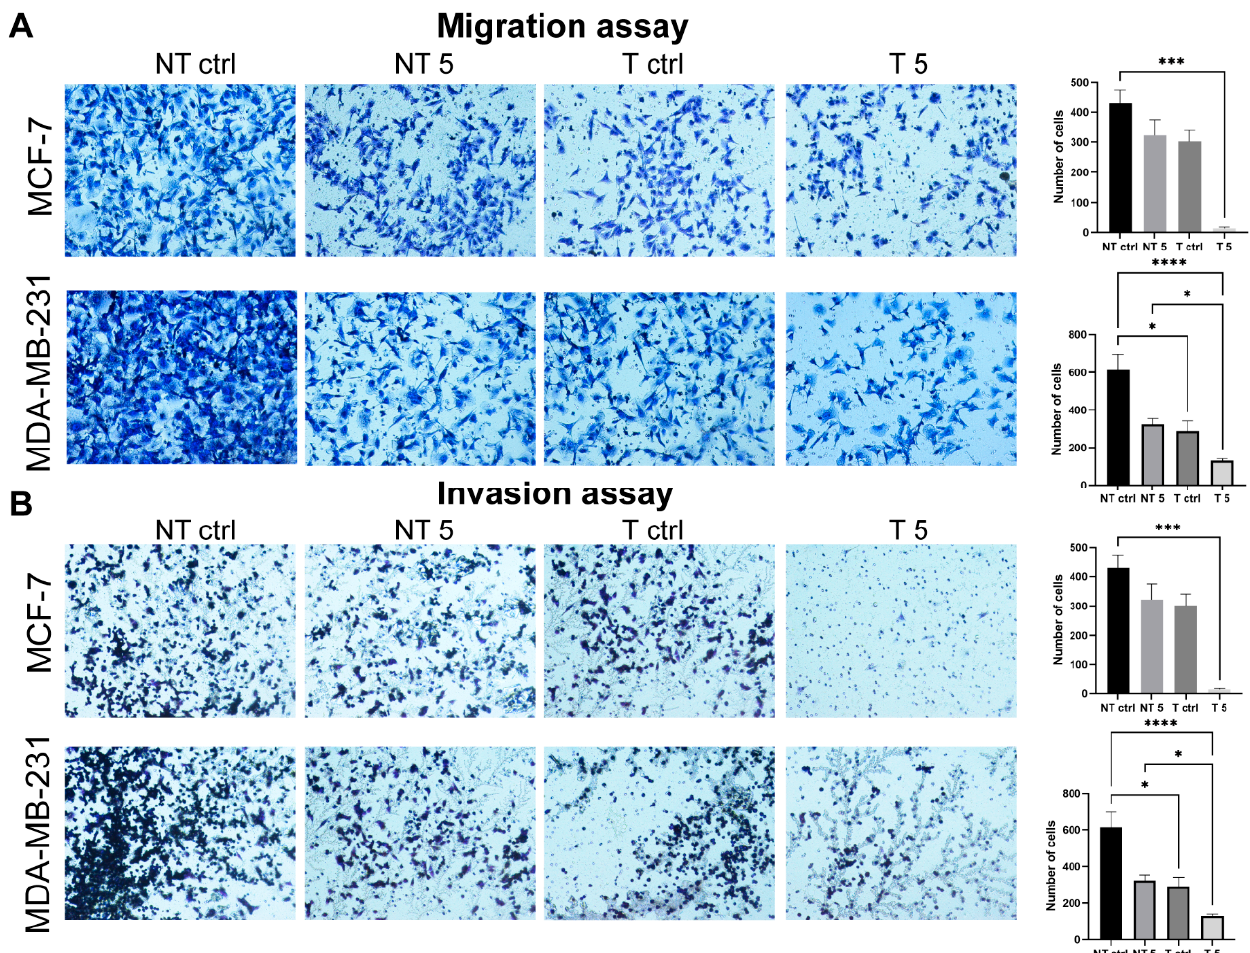
Figure 4. The effect of MMP-9 downregulation on metastasis potential of MCF-7 and MDA-MB-231 breast cancer cell lines. ( A ) migration and ( B ) invasion assay. NT—non-transfected cells, T—cells transfected with MMP-9 siRNA, NT5 and T5 non-transfected and transfected cells treated with 5 mM cyclophosphamide for 24 h. Magnification 400 × ( A ) Representative image of transwell migration assay and number of cells with high migratory potential. Data represents the mean ± SD obtained from 6 independent replicates (n = 6). Statistically significant differences were marked with ‘*’ p ≤ 0.05, ***’ p ≤ 0.001, and ‘****’ p ≤ 0.0001 (Kruskal-Wallis test). ( B ) Representative image of invasion assay and number of cells with high invesion potential. Data represents the mean ± SD obtained from 6 independent replicates (n = 6). Statistically significant differences were marked with ‘*’ p ≤ 0.05, ‘***’ p ≤ 0.001, and ‘****’ p ≤ 0.0001 (Kruskal-Wallis test).